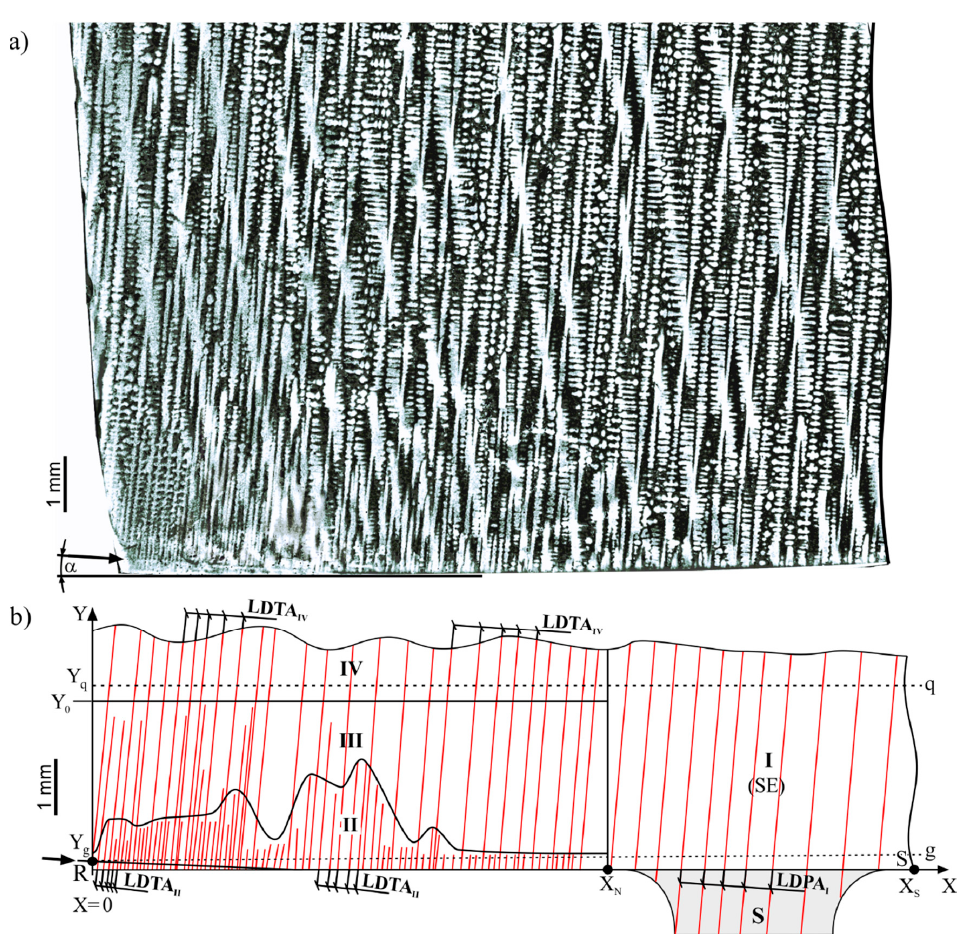
Figure 4. ( a ) The dendritic structure visualized on the surface F* of the root part T; ( b ) the dendritic array scheme with growth areas marked as I, II, III, and